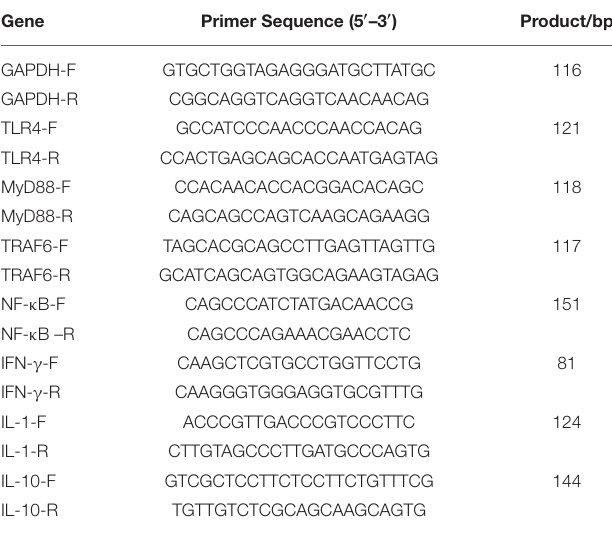
TABLE 3 | Primer sequences for quantitative real-time PCR